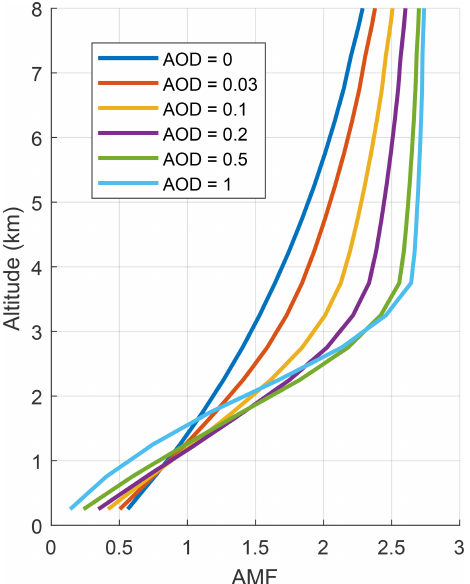
Figure 6. Example AMFs as a function of altitude for various AODs for a 0–3km smoke plume. AMFs are shown for clear skies above the plume. SZA: 30 ◦ , viewing zenith angle: 50 ◦ , albedo: 0.03, sur- face pressure: 1000hPa, and column ozone: